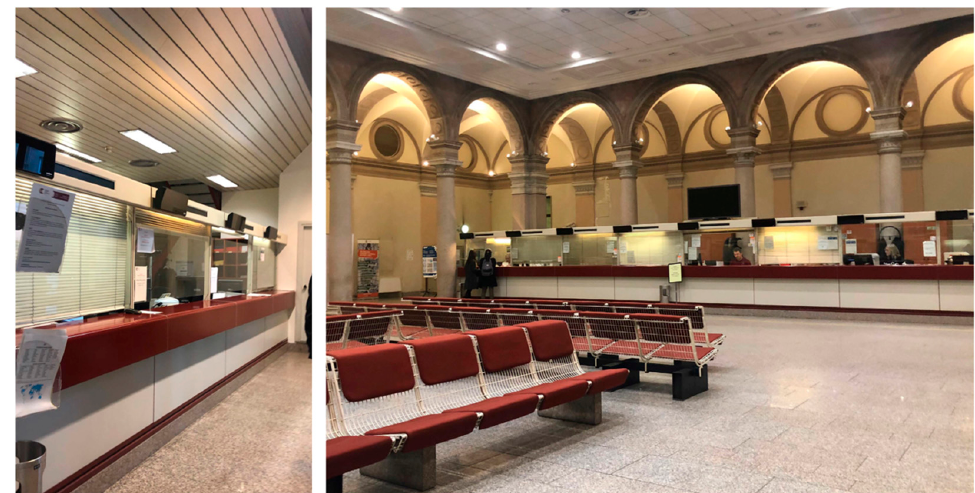
Figure 3. The waiting system and the counters of the hall before restoration.